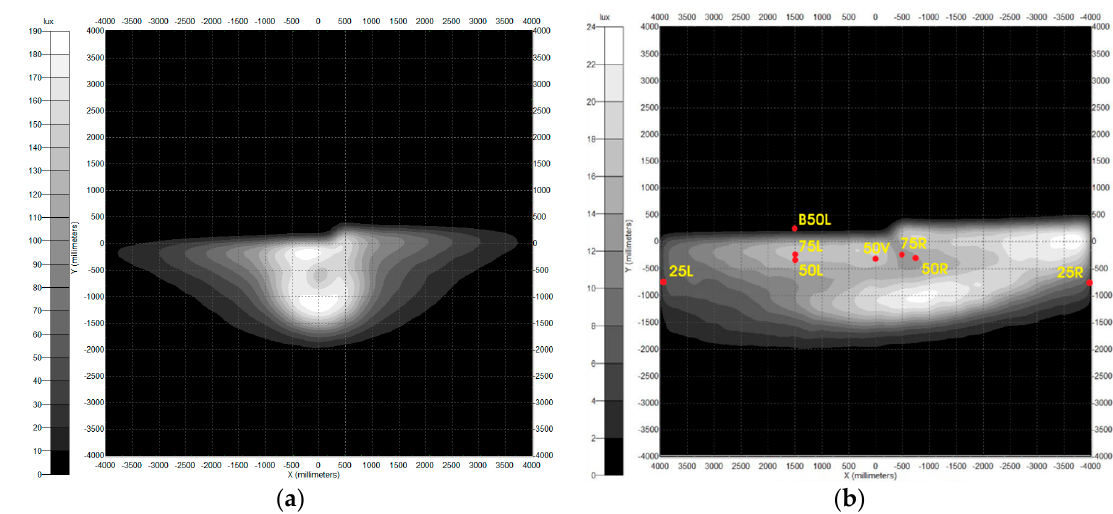
Figure 5. Simulated illuminance distributions of low-beam headlamps with the ( a ) symmetrical ellipsoidal reflector and ( b ) expanding ellipsoidal reflector.